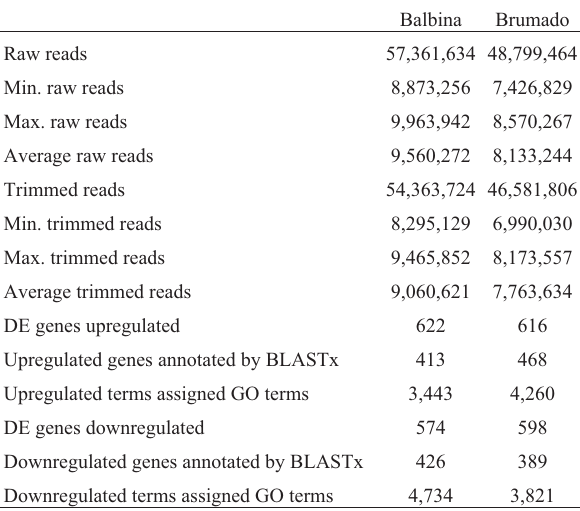
Table 1 - Summary of the Illumina sequencing statistics.